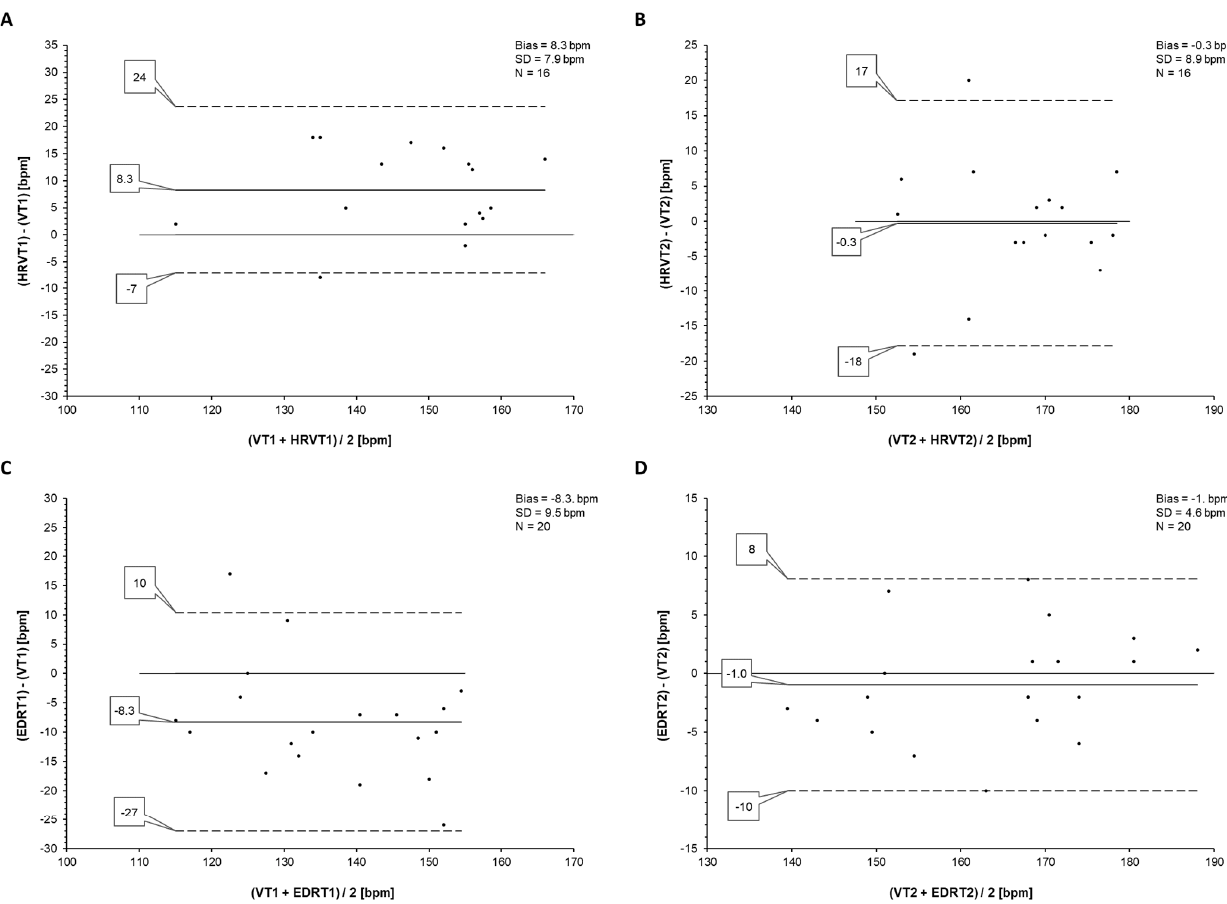
Figure 3. Bland–Altman analysis for VT1 vs. HRVT1 ( A ), VT2 vs. HRVT2 ( B ), VT1 vs. EDRT1 ( C ), VT2 vs. EDRT2 ( D ), VT1 vs. Combo1 ( E ), and VT2 vs. Combo2 ( F ) with bias, standard deviation (SD), and total tests compared (N). Center line in each plot represents the mean difference between each paired value; the top and bottom lines are 1.96 SD from the mean difference. 5. Discussion In past reports, each single surrogate modality (e.g., HRVT, EDRT) showed reasona- ble agreement to the “gold standard” group averages but variable degrees of deviation at the individual level [20,24,25]. Although validation with established threshold methodol- ogy is the scientific standard introducing novel approaches, it should be understood that